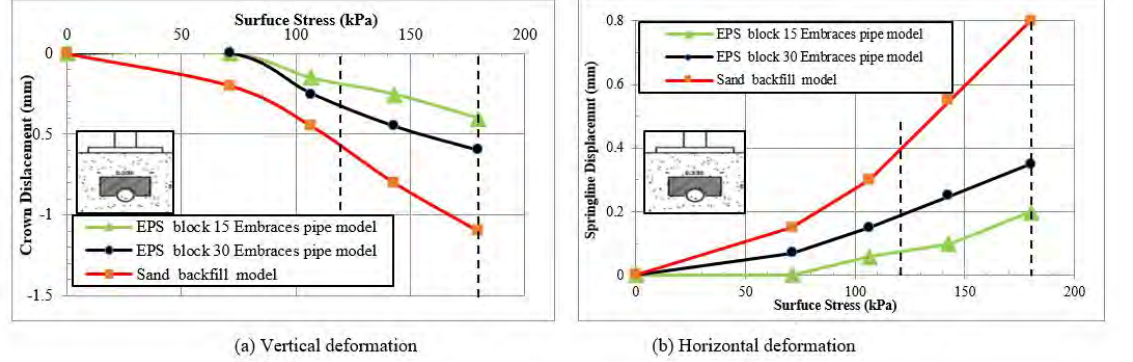
Figure 8. Deformation of UPVC buried pipe under Embedded EPS blocks embraces thepipe upper part model